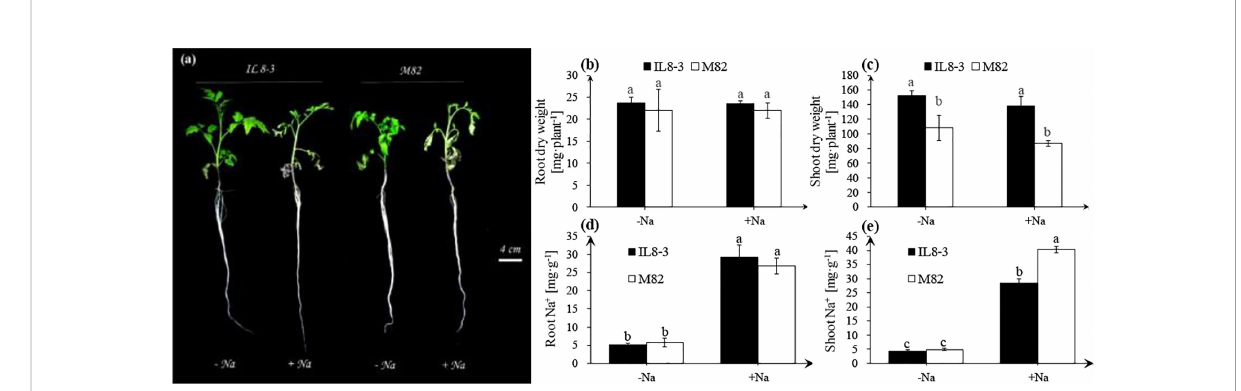
FIGURE 1 Tomato growth and physiological indices (A) , the alterations of root dry weight (B) , shoot dry weight (C) , root Na + content (D) , shoot Na + content (E) under NaCl-free condition (-Na) and 200 mM NaCl stress (+Na). The seedlings of two tomato genotypes, IL8-3 (tolerant to salt stress) and M82 (sensitive to salt stress), were grown under nutrient solution without NaCl for 30 days, then the seedlings shift to nutrient solution with or without 200 mM NaCl for 3 days. Values represent the mean ± SD of four independent replicates, bars with different letters show signi fi cant differences (ANOVA, LSD, P